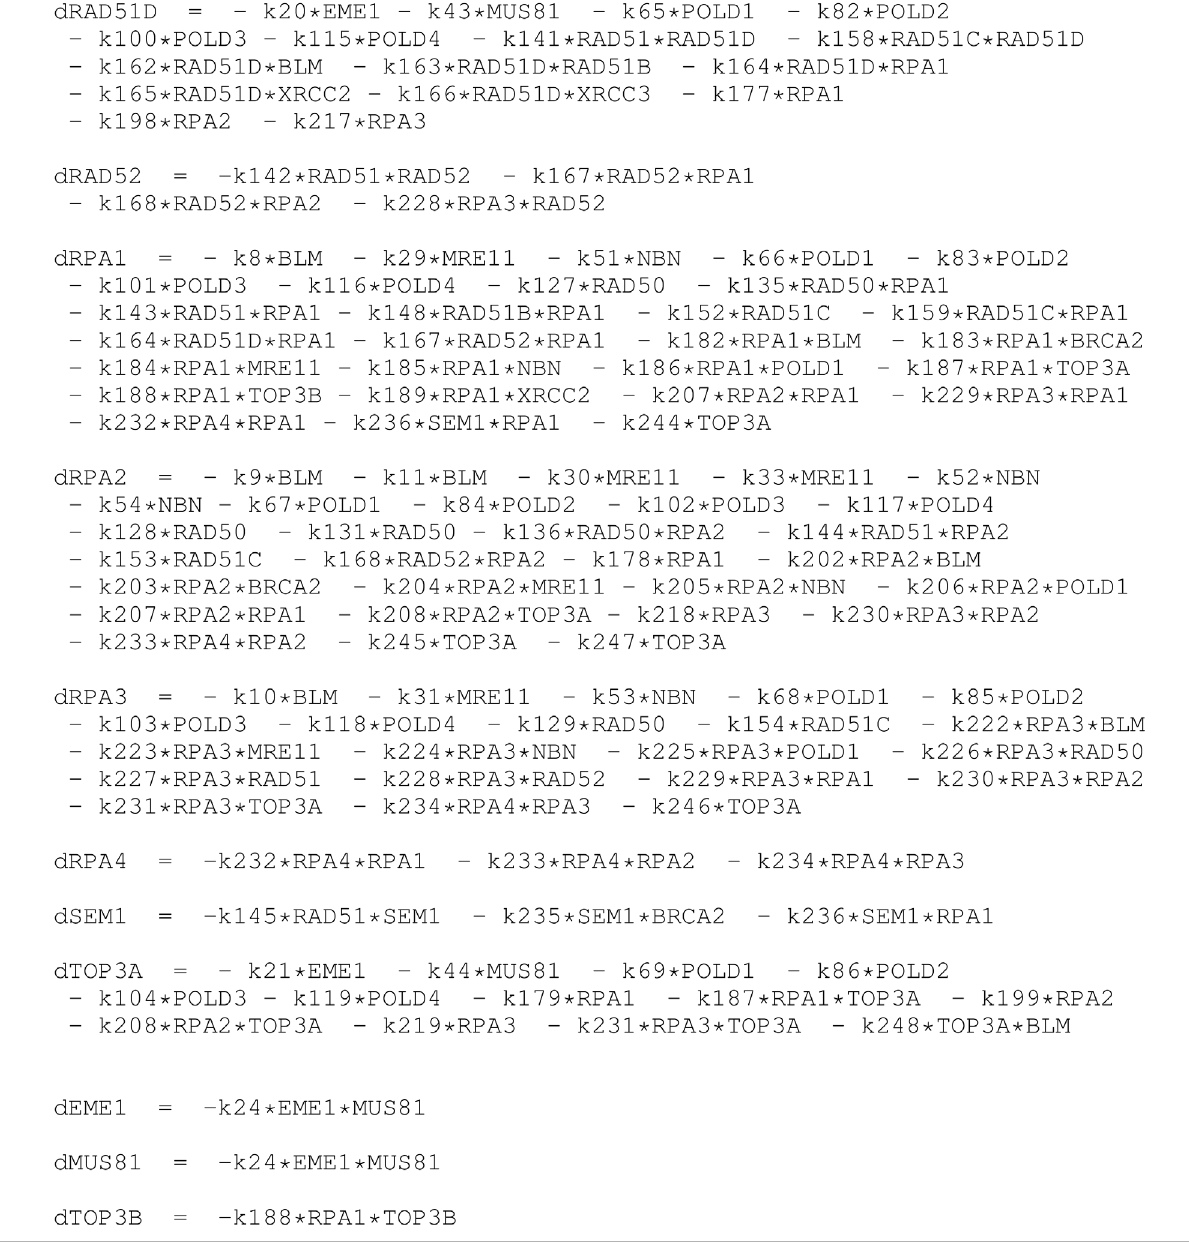
TABLE 6 | This is the PART II (continuation) of the table of ordinary differential equations of the dynamics of HR network, in R code formalism. The k followed by a number denote the kinetic rate constant, and the letter “ d ” in front of the name of the proteins denote the temporal derivative of it concentration.